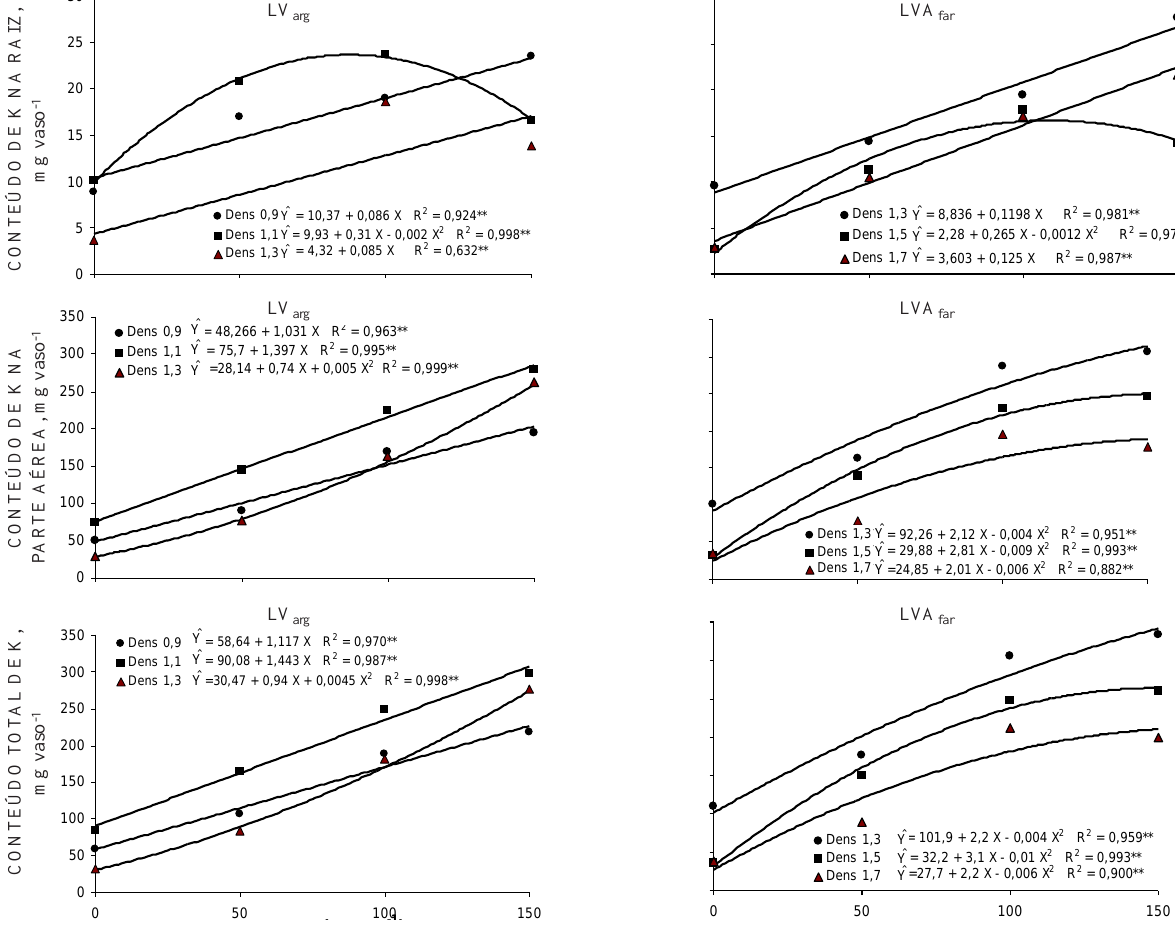
DOSE DE K, mg kg ) e franco-arenosa (LVA ), com diferentes densidades e arg far